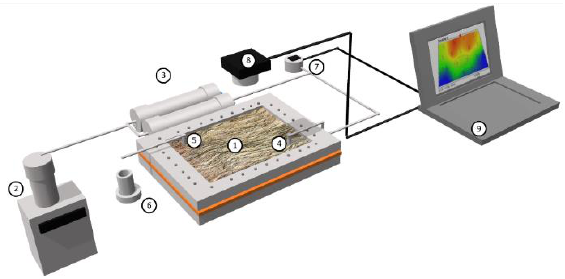
Figure 13. Experimental setup of a quarter five-spot pattern micromodel: (1) Ottawa Sand packing; (2) injection pump; (3) displacement cylinder; (4) injection point; (5) production point; (6) test tube; (7) pressure sensor; (8) digital camera and (9) data acquisition. The dimensions of the cell are 25 cm × 12 cm × 2 cm.